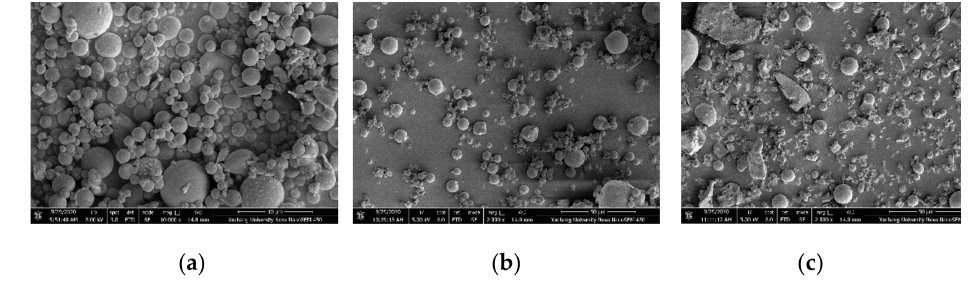
Figure 2. SEM image of fly ash: ( a ) raw fly ash; ( b ) sorted fly ash; ( c ) ground fly